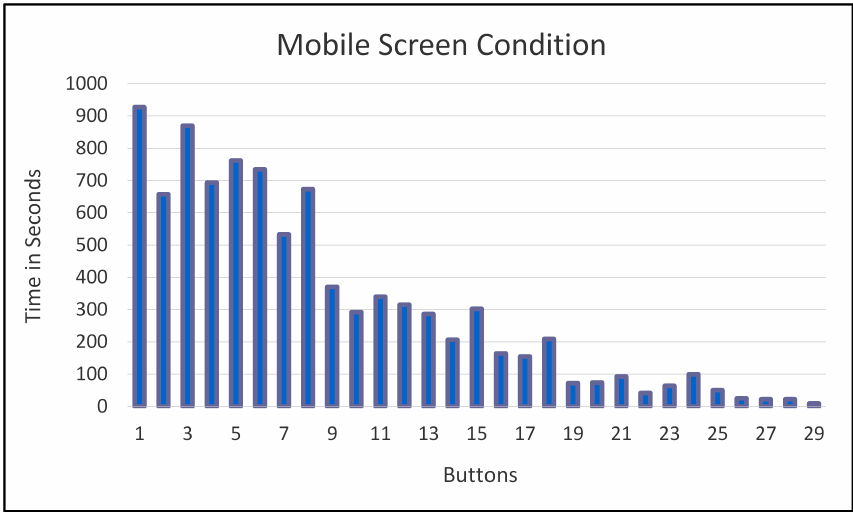
Figure 9. Line graph of time spent on each page in case of mobile screen